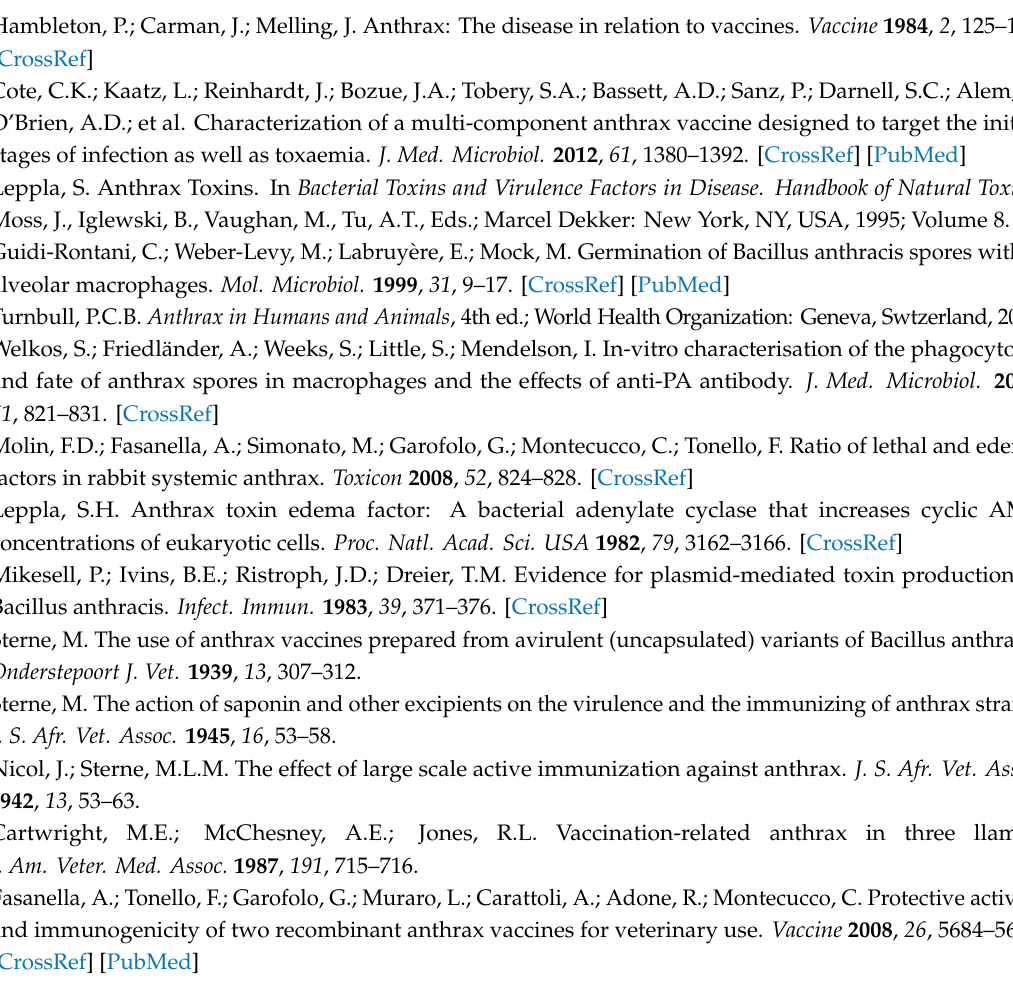
Table S1. The Anti-recombinant protective antigen (rPA) and anti-formalin inactivated spores (FIS) IgG titres (log10) in cattle vaccinated at weeks 0 and 3 and measured at weeks 0, 3, and 5 (with means and standard deviations). Cattle were vaccinated twice (weeks 0 and 3) with purified rPA (PrPA) + FIS + Pen-G (penicillin-G), crude rPA (CrPA) + FIS + Pen-G, SLSV + FIS + Pen-G, SLSV and NegCtl + Pen G (vaccinated with Emulsigen-D ® / Alhydrogel ® plus Pen-G), Table S2. The anti-recombinant protective antigen (rPA) and anti-formalin inactivate Bacillus anthracis 34F2 spores (FIS) titres (log10) of di ff erent isotypes in vaccinated cattle (with means and standard deviations) of immunoglobulin isotypes titre of vaccinated cattle measured at weeks 0, 3 (two weeks after first vaccination) and 5 (two weeks after second